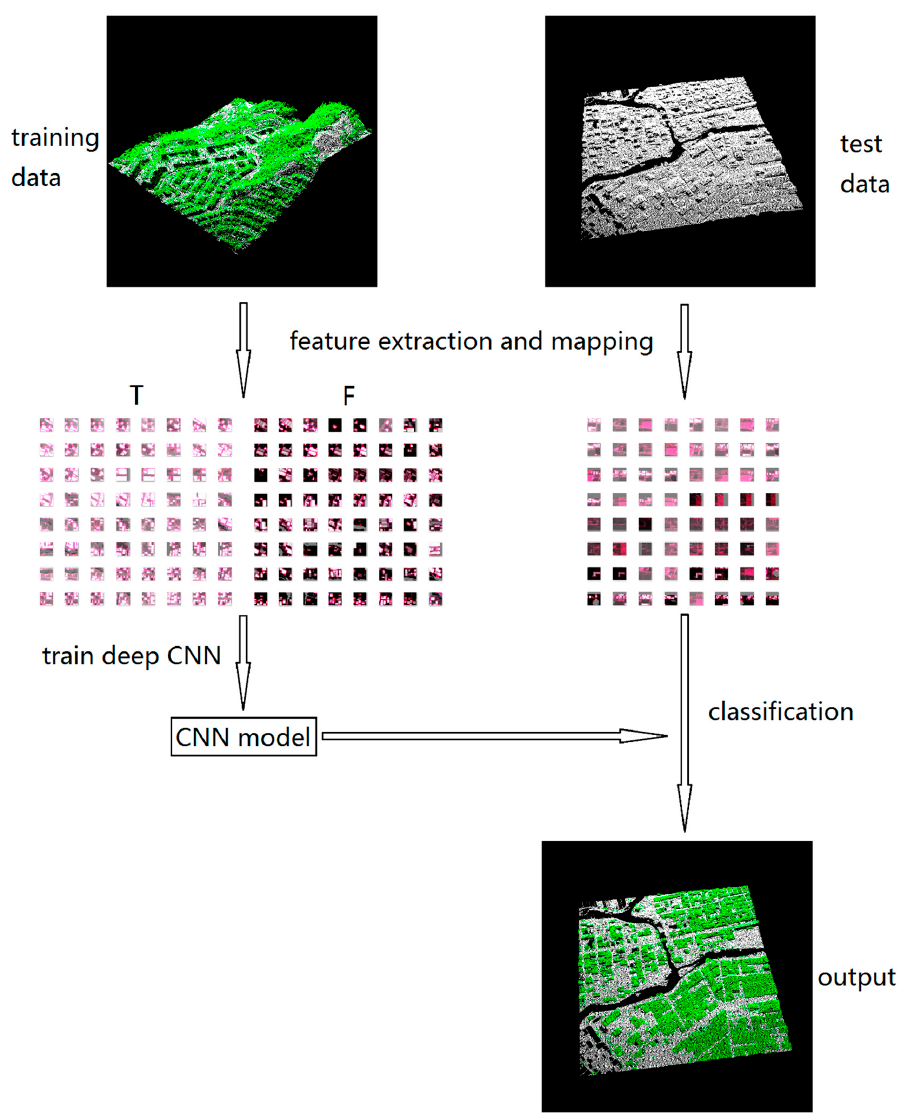
Figure 1. Workflow of the proposed approach. “T” means the samples of ground points and “F” means the samples of non-ground points.